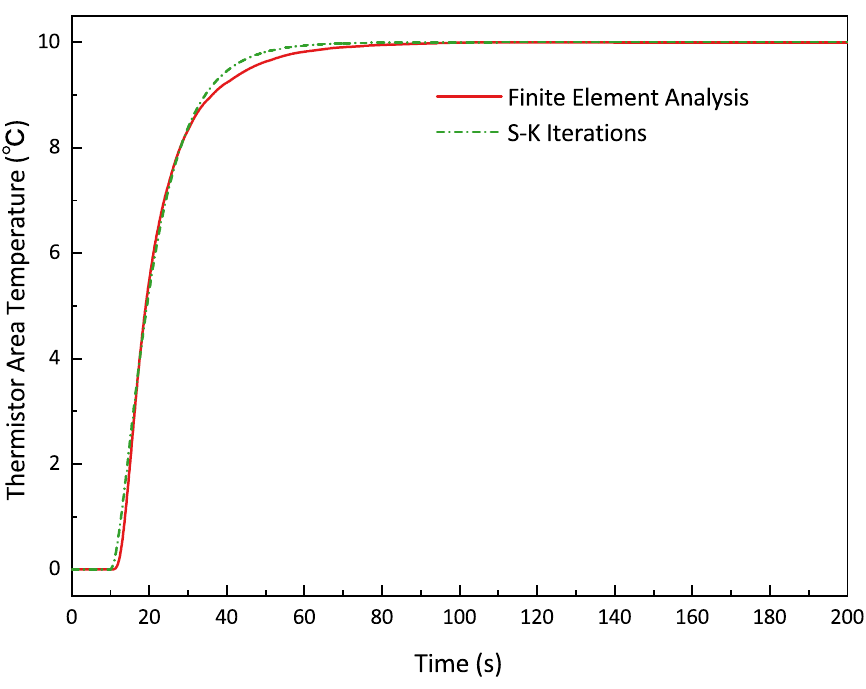
Figure 6. Finite element simulation and S-K iterative fitting of temperature